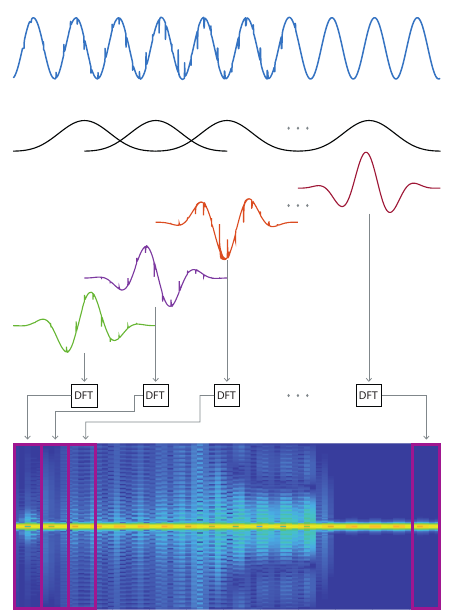
Figure 4. Short time Fourier transform